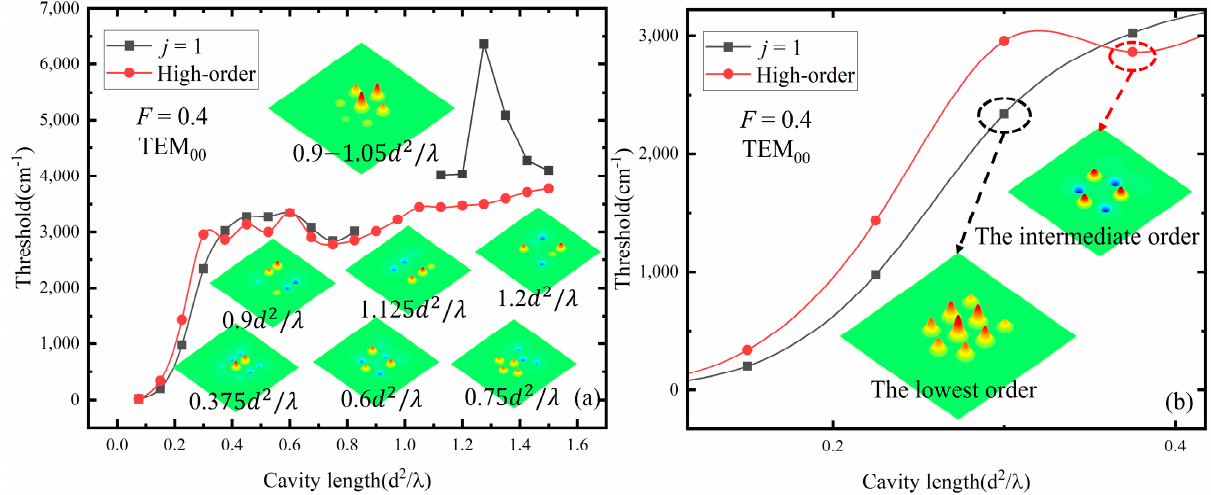
Figure 3. ( a ) The change of the threshold of the lowest order supermode (hexagonal array composed of TEM 00 elements) and the minimum threshold of other intermediate supermodes versus the external cavity length, and the amplitude distributions of the near-field of various possible simultaneous production of intermediate supermodes at some planes with the duty ratio F = 0.4; ( b ) enlarged view of the cavity length of 0.15 − 0.5 d 2 / λ and the near-field distributions of the lowest supermode and the intermediate supermode.